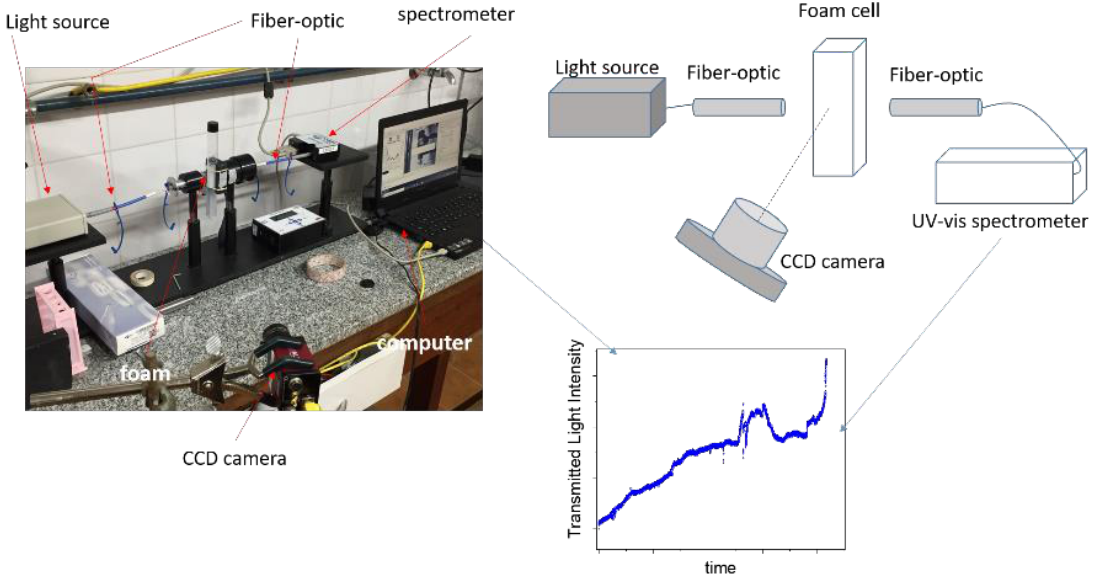
Figure 3. Scheme and photo of the device used to study foam dynamics. The intensity of the light transmitted through the foam sample is measured as a function of time by means of a UV-vis spectrometer. The temporal evolution of the foams is observed and recorded with a CCD camera.